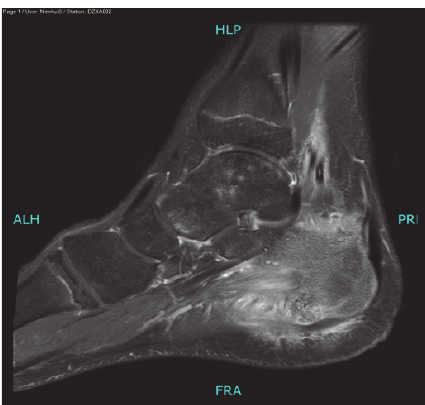
Figure 4: MRI T1 fat suppression after gadolinium: sagittal view of the left foot: attenuation of soft tissue near the